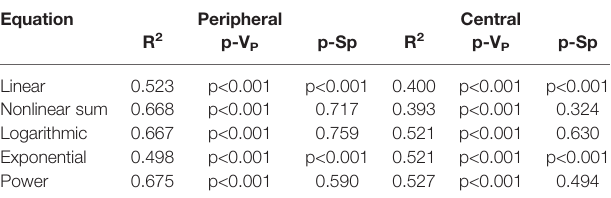
TABLE 3 | Fitting results of GM on bivariaty (V P and Sp) for different equations. Equation